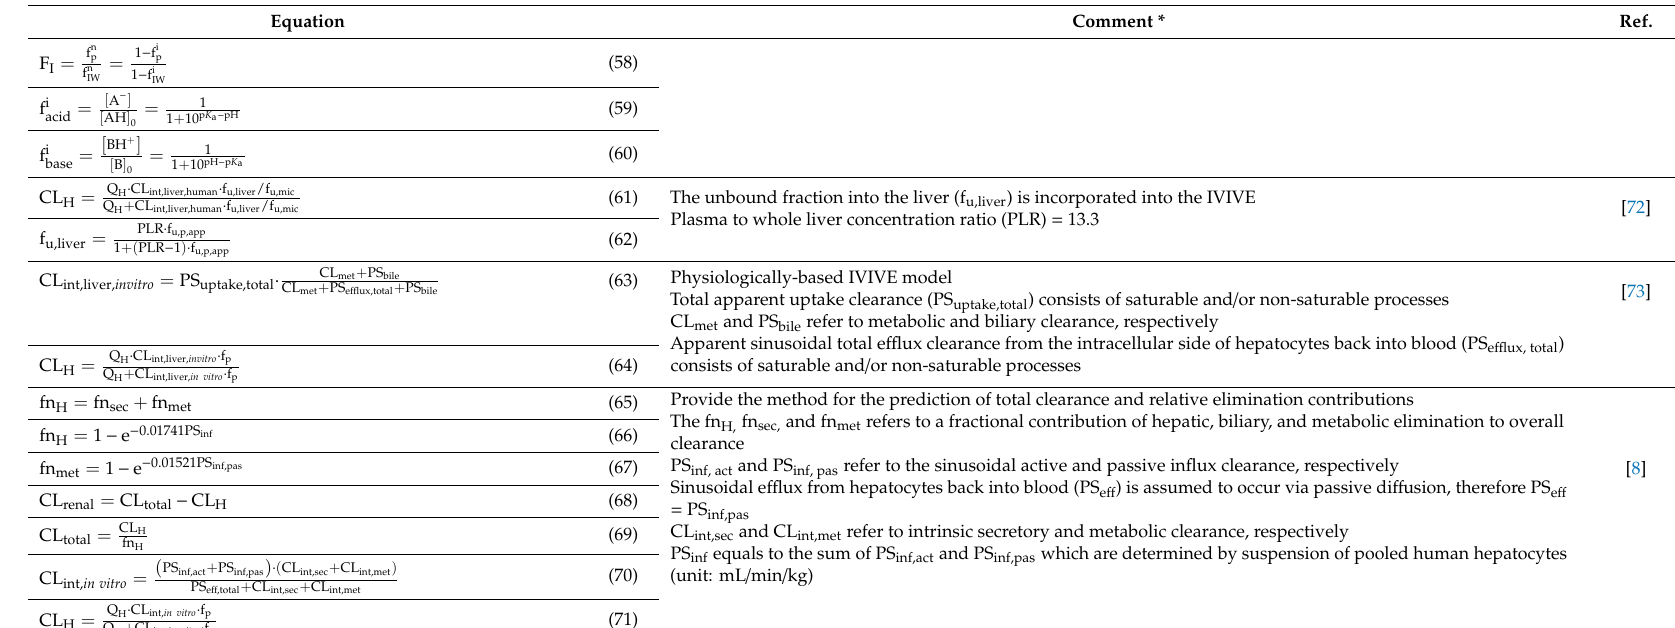
* Each comment corresponds to all the equations within each major section of the table defined by horizontal